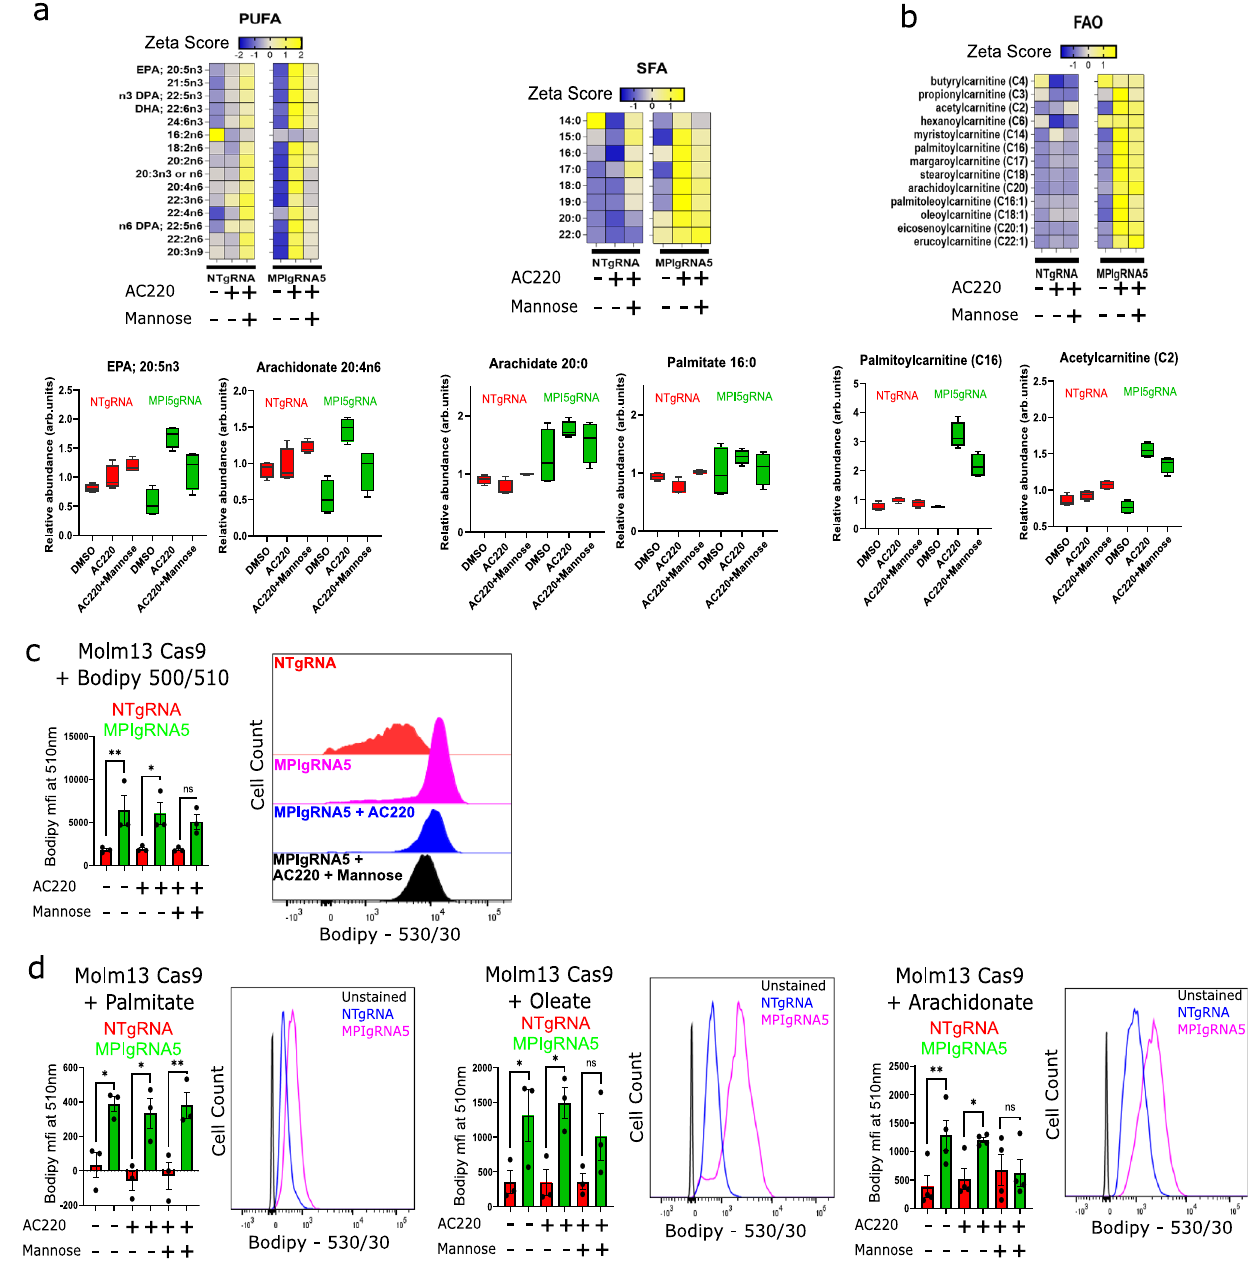
Fig. 3 | MPI KO causes increased lipid uptake in AML cells. a Heat maps of Z-scores for relative changes of long chain polyunsaturated fatty acids (PUFA - n3, n6 and n9, left) and long chain saturated fatty acids (SFA, right), with box plots of selected lipids of each type below the heat maps from global metabolomics of MOLM13NTgRNAorMPIgRNA5cellstreatedwithvehicle,AC220(1nM)orAC220 (1nM)andmannose(100 µ M)asindicatedfor48h, N =4;( b )HeatmapsofZ-scores for relative changes of fatty acid oxidation metabolism related fatty acid species, withboxplotsof selected lipidsbelowtheheatmapsfromglobalmetabolomicsof MOLM13NTgRNAorMPIgRNA5cellstreatedwithvehicle,AC220(1nM)orAC220 (1nM)and mannose (100 µ M)asindicated for 48h, N =4;( c )Uptake of fl uorescent C1-Bodipy 500/510 C12 by NT gRNA or MPI gRNA5 MOLM13 cells treated with vehicle, AC220 (1nM) or AC220 (1nM) and mannose (100 µ M) for 24h, with a